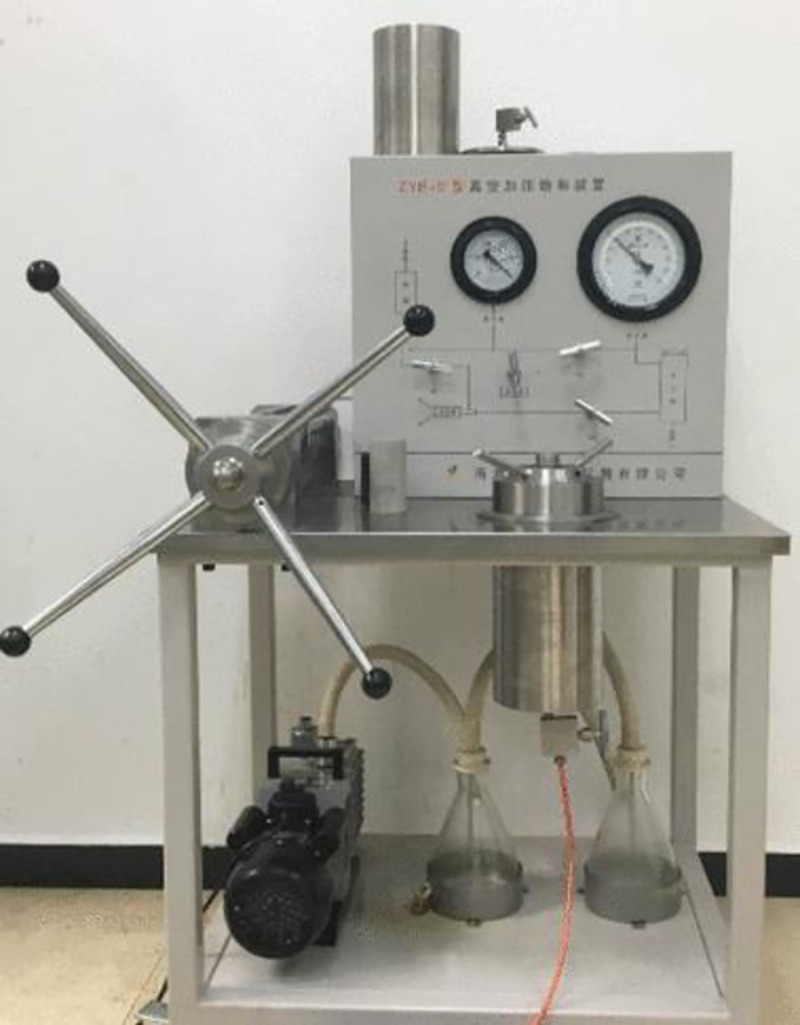
Water-saturated apparatus [33].